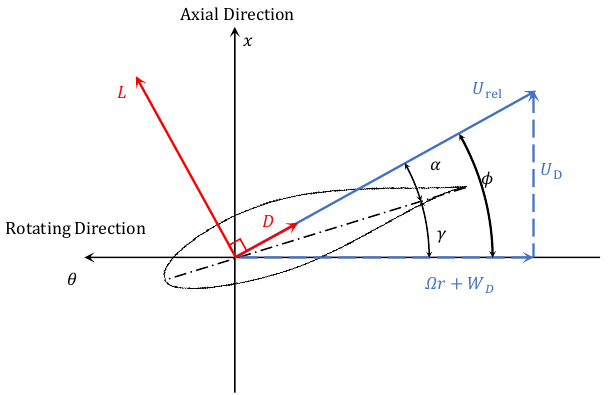
Figure 2. A two-dimensional cross-section of a blade for computing the lift and drag forces in the actuator line